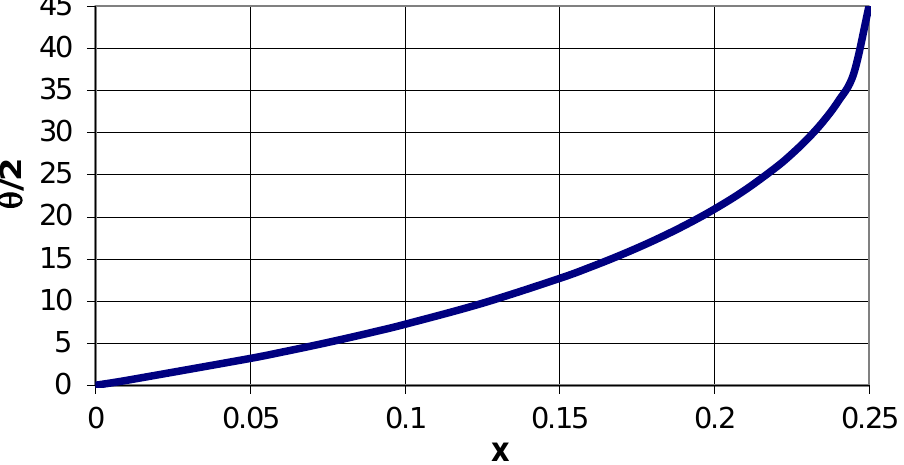
Figure 4. The theoretical relationship between the internal angle of the structure and the parameter x.